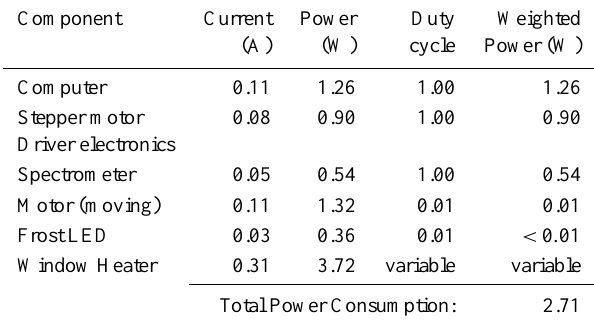
Table 1. The power budget of the MAX-DOAS instrument mea- sured in the laboratory at 12V DC. The weighted power is the product of the duty cycle and the power consumption of each com- ponent. The window heater is not included in the total power con- sumption because its duty cycle varies strongly with weather condi-